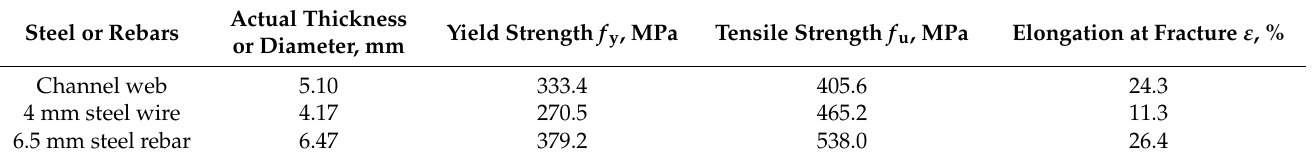
Table 2. Material properties of the steel and steel bars.